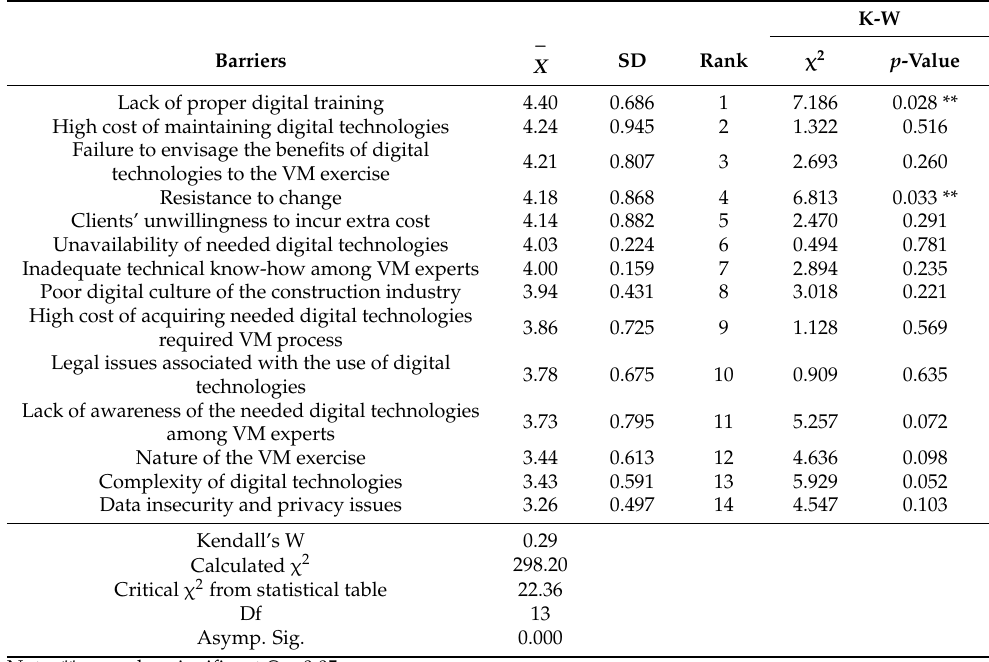
Table 3. Barriers to the use of digital technologies for VM